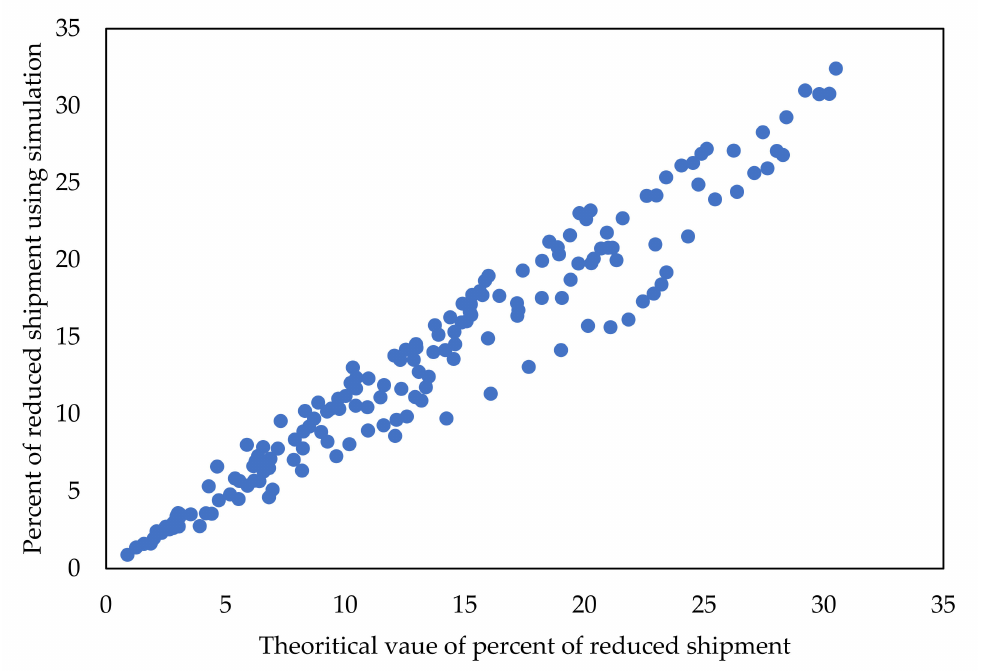
Figure 7. Accuracy of the formula in Equation (1).